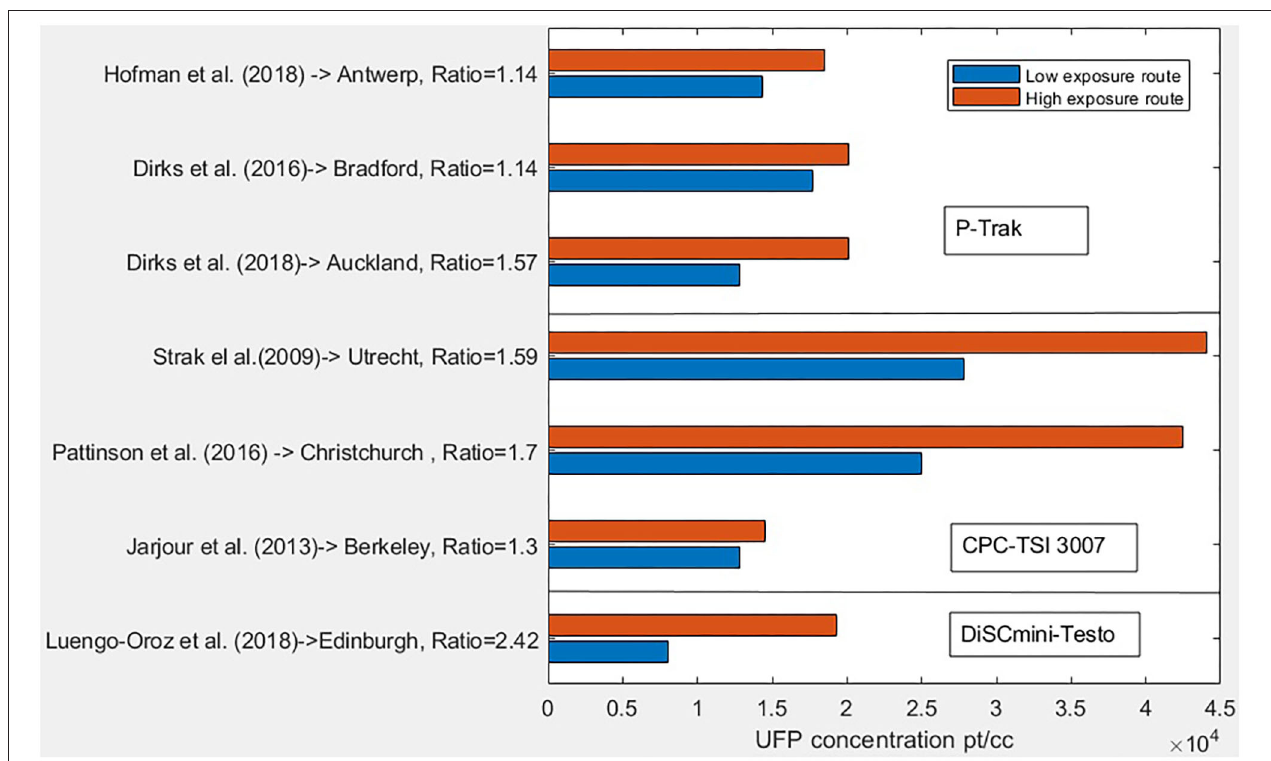
FIGURE 2 | Comparison of the concentration of UFP in the studies. High exposure is in orange color and the low exposure in blue. The ratio is the mean of high exposure divided to the low exposure route.